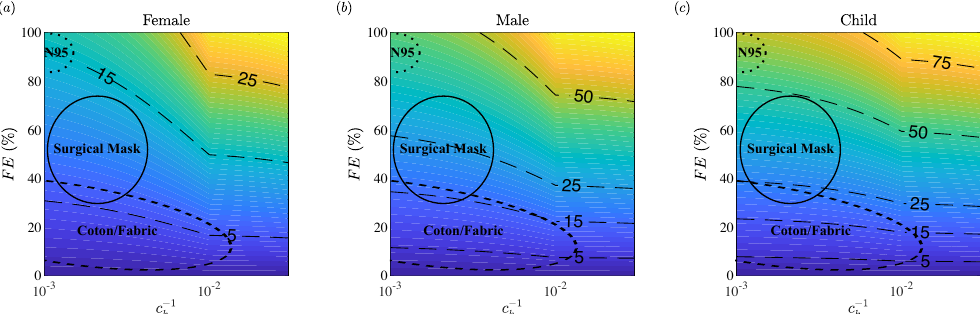
Figure 7. The fitted filtration efficiency FFE as a function of porosity and mask filtration efficiency for ( a ) female face, ( b ) male face, and ( c ) child